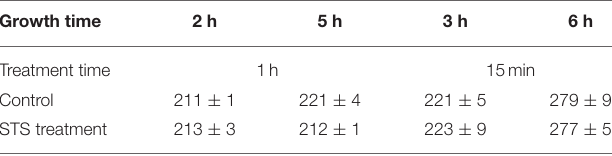
TABLE 1 | Values of dipole potential ψ d in mV obtained through Equation 1. Growth time 2 h 5 h 3 h 6 h Treatment time 1h 15min Control 211 ± 1 221 ± 4 221 ± 5 279 ± 9 STS treatment 213 ± 3 212 ± 1 223 ± 9 277 ± 5